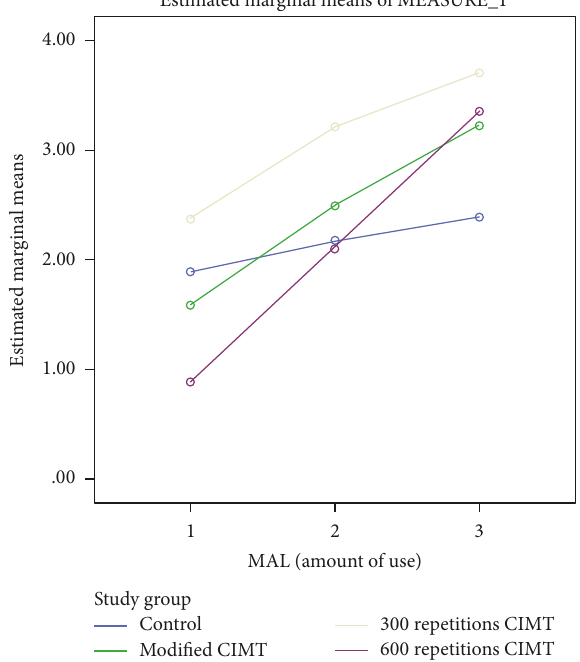
Figure 4: A profile plot showing groups’ mean scores in MAL (amount of use) at baseline, 2 weeks, and 4 weeks after intervention.